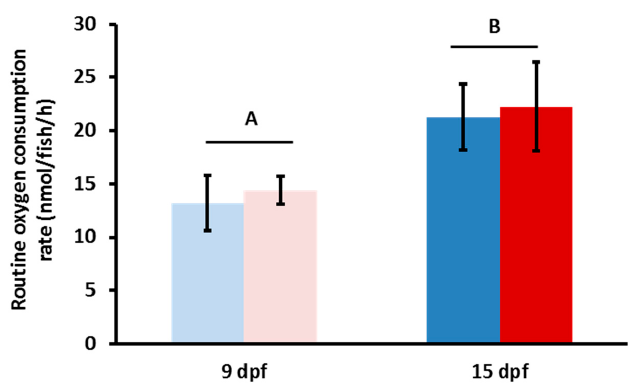
Figure 1. Oxygen consumption rates (OCRs) for microplastic (MP) exposed zebrafish. OCRs of MP fish after 5 days (pink) and 10 days (red) of exposure to MP and the respective age matched control fish (light blue/dark blue). No statistical significance was observed between the MP and control groups; however, there was a significant difference between time points ( n = 6, p = 0.015).